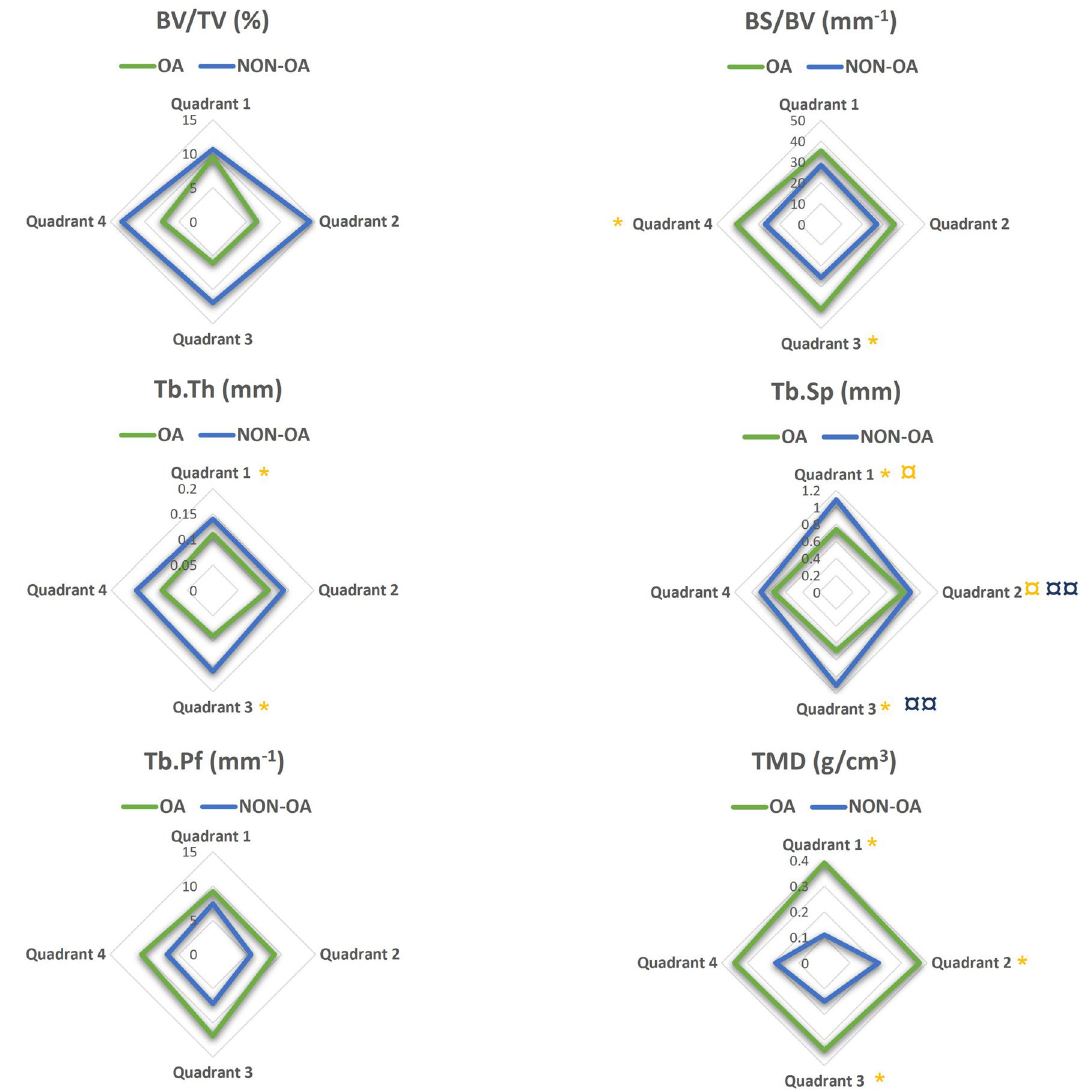
Figure 6. Regional distribution of the median value for the trabecular microstructural parameters evaluated in OA (green) and non-OA (blue) patients. No significant differences were found when subchondral trabecular in different anatomical regions were compared within the OA patients. (¤ and ¤¤) shows there is a significant difference between quadrants 1 and 2, and 2 and 3 respectively in non-OA patients. (*) shows a significant difference between OA and non-OA patients ( p < 0.05). BV/TV: bone volume fraction; BS/BV: bone specific surface; Tb.Th: trabecular thickness, Tb.Sp: trabecular separation; Tb.Pf: trabecular pattern factor; TMD: tissue mineral density.